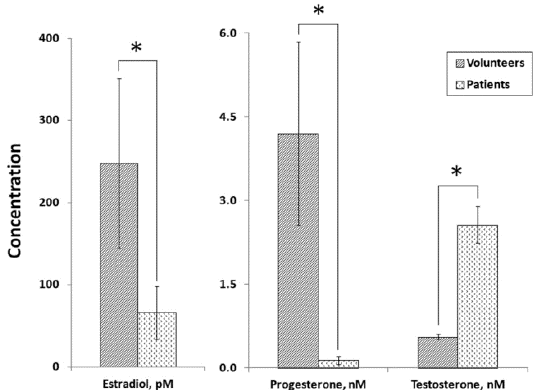
Figure 1. The levels of sex hormones in the blood of psoriasis patients and healthy volunteers that participated in the qPCR and ELISA experiments. The following individuals participated in these experiments: psoriasis patients without menopause (n = 10); psoriasis patients with menopause (n = 10); healthy volunteers without menopause (n = 6); and healthy volunteers with menopause (n = 5). * p < 0.05 when patients compared to healthy volunteers. Table 3. The levels of sex hormones in blood samples of qPCR/ELISA participants with and without menopause. pM and nM are concentrations (pmol/L and nmol/L,